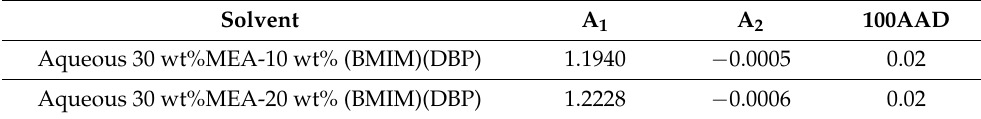
Table 2. Fitting parameters of Equation 5 to correlate density ( ρ ) of aqueous 30 wt% MEA - 203 (BMIM)(DBP). Table 3. Fitting parameters of Equation (6) to correlate viscosity ( η ) of aqueous 30 wt% MEA-